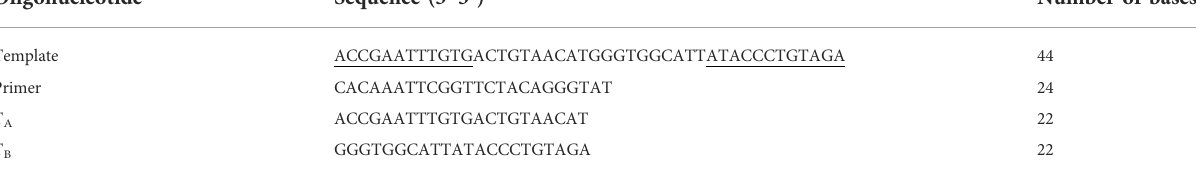
TABLE 1 Oligonucleotide sequences used in this assay a,b